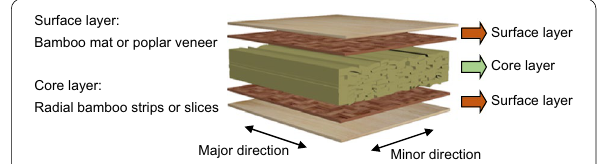
Fig. 3 A schematic layup used for making overlaid laminated